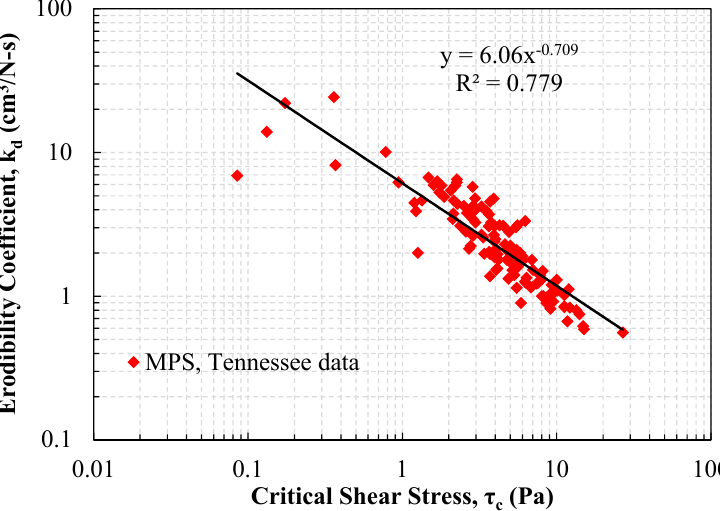
Figure 6. Relationship between critical shear stress ( τ c ) and erodibility coefficient ( k d ) using the MPS method data from this study.